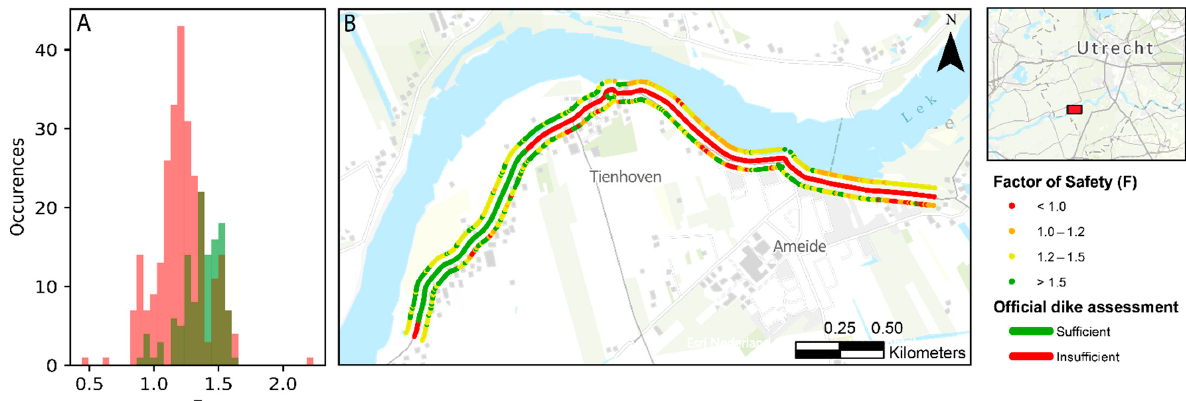
Figure 11. Comparison between official preliminary dike safety assessment and safety factors derived from our database. The histograms ( A ) of the safety factors corresponding to the sufficiently safe (green) or insufficiently safe (red) dike segments clearly show a clear distinction in our database between these segments. Spatially ( B ), both inner and outer slope stability show a much larger variation in safety factors than the official dike assessment suggests.